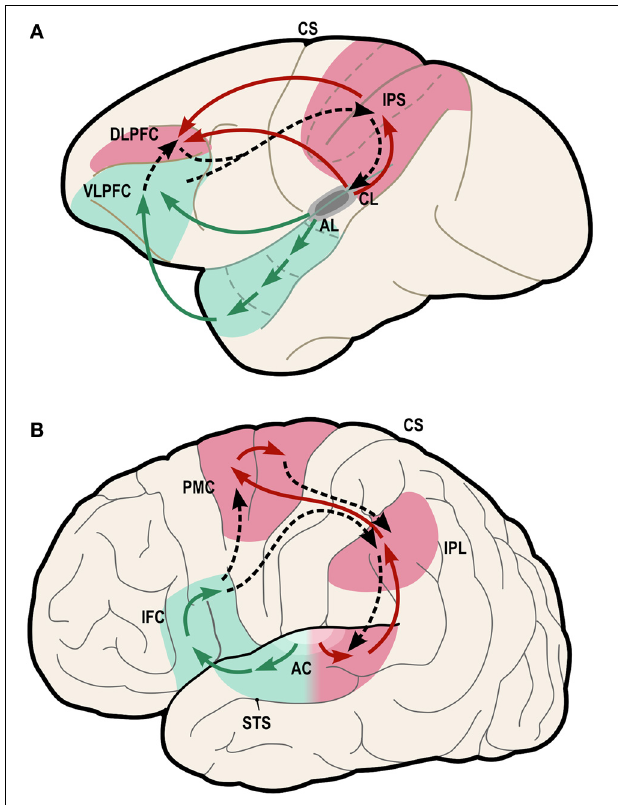
FIGURE 4 | Model of dual-stream auditory processing in the primate brain, from Rauschecker (2011). Dorsal (red) and ventral (green) auditory pathways are shown in the macaque brain (A) and the human brain (B) . Solid arrows indicate ascending projections from auditory cortex, while dashed arrows indicate reciprocal projections back to the auditory cortex. AC, auditory cortex; AL/CL, anterolateral/caudolateral superior temporal gyrus; CS, central sulcus; DLPFC, dorsolateral prefrontal cortex; IFC, inferior frontal cortex; IPL, inferior parietal lobule; IPS, inferior parietal sulcus; PFC, prefrontal cortex; PMC, premotor cortex; STS, superior temporal sulcus; VLPFC, ventrolateral prefrontal cortex.